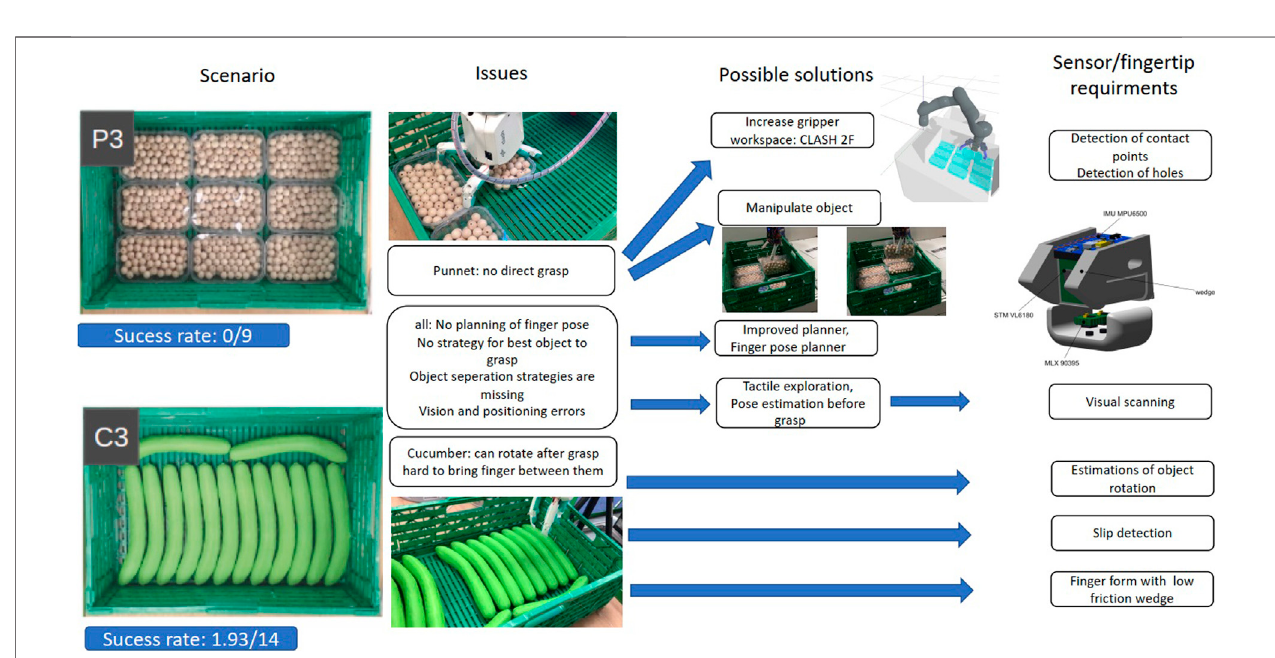
FIGURE12| DerivationofrequirementsfromthebenchmarktestsbyanalyzingtheoriginalfailuresforthestudyfromMnyusiwallaetal.(2020)foracratecompletely fi lled with punnets (scenario P3) or cucumbers (scenario C3).